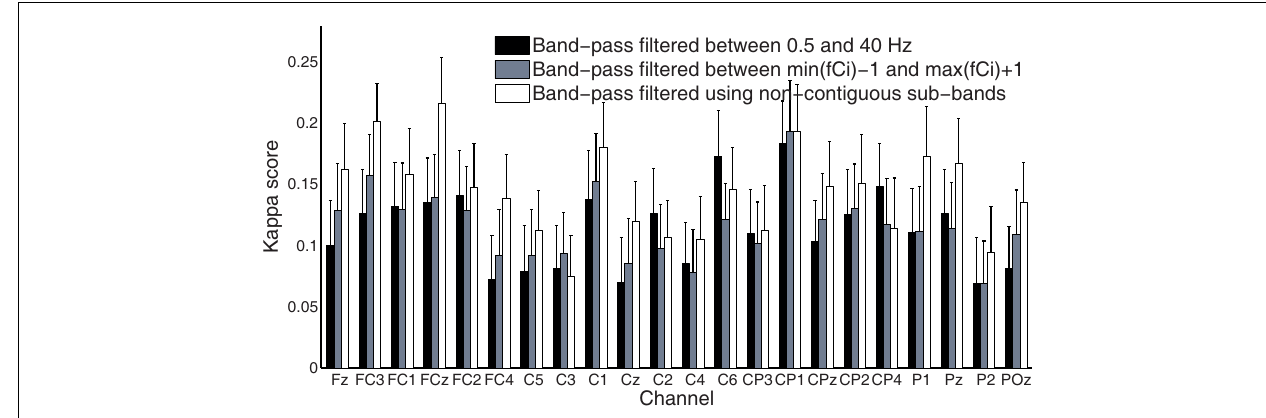
FIGURE 5 | Comparison of kappa scores using three different filtering approaches.